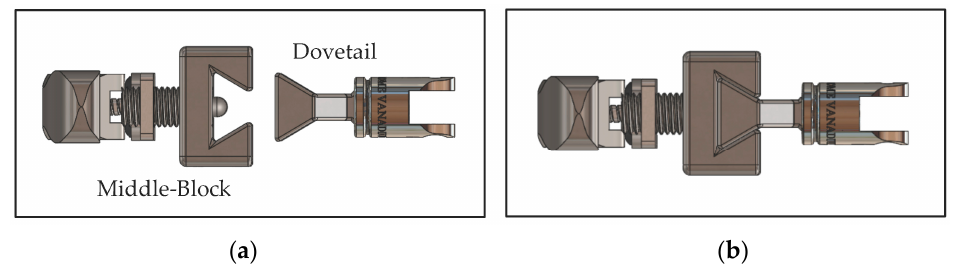
Figure 5. Dovetail concept: ( a ) Detached; ( b ) Attached.